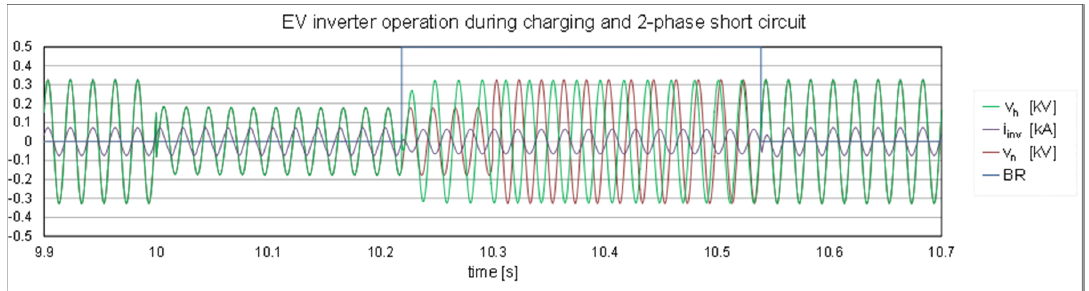
Figure 7. Inverter voltage and current and the network voltage during charging, 2-phase short circuit, island operation and again charging. The BR signal equal “0” means that BR breaker is closed.